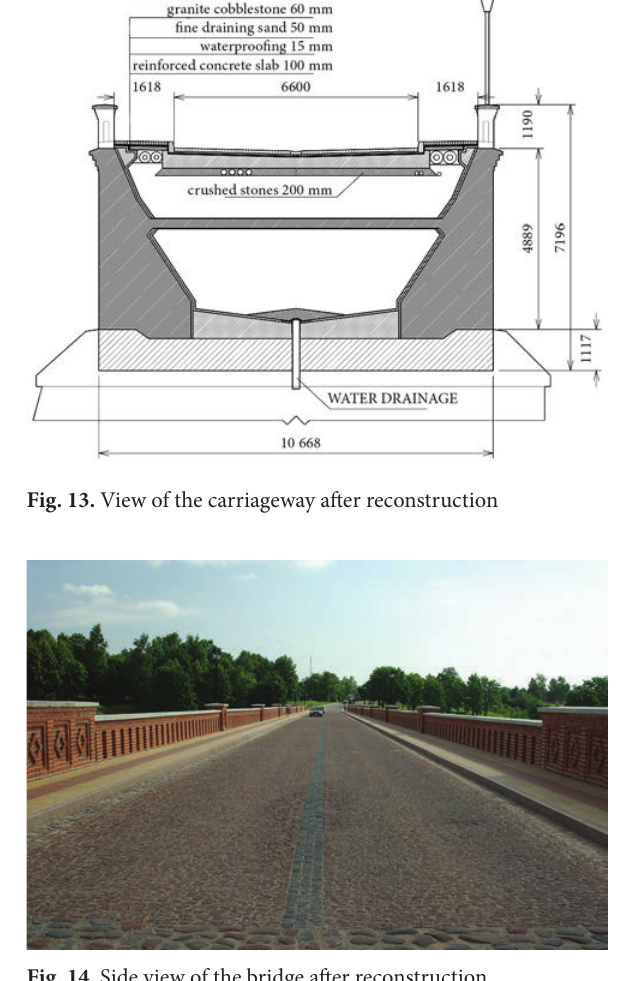
Fig. 14. Side view of the bridge after